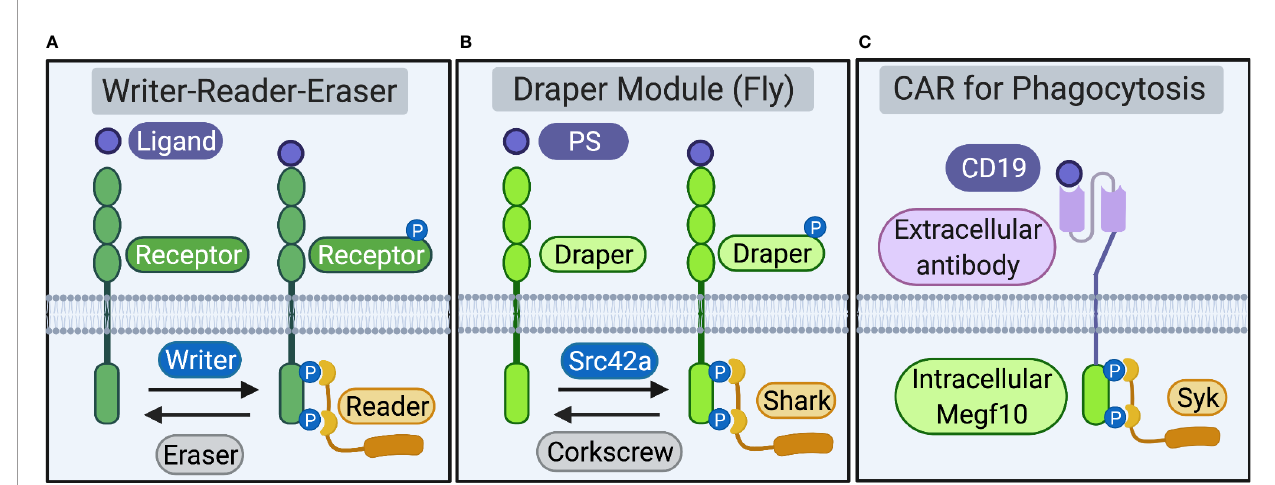
FIGURE 1 | Receptors and proximal writer-reader-eraser modules. (A) Schematic of a generalized receptor and writer-reader-eraser module. Receptor ligation induces phosphorylation of a receptor intracellular signaling domain by a writer kinase. The phosphorylated receptor recruits a reader adaptor protein. An eraser phosphatase removes phosphorylation marks on the receptor intracellular domain, returning the system to its resting state. (B) A writer-reader-eraser module regulates signal transduction through the Draper receptor. Draper, expressed on fruit fl y phagocytes, recognizes phosphatidylserine (PS) or other ligands. Phosphorylation of the Draper intracellular domain by the kinase Src42a induces recruitment of the adaptor kinase Shark. The phosphatase Corkscrew erases phosphorylation marks on the intracellular domain of Draper. (C) Chimeric Antigen Receptor for Phagocytosis (CAR-P). Synthetic CAR-Ps bind cancer antigens (e.g. the B cell antigen CD19) via an extracellular single-chain antibody fragment (scFv). Extracellular antibody ligation induces phosphorylation of engulfment receptor signaling domains (e.g. the intracellular domain of mouse Megf10). Phosphorylation of the Megf10 receptor signaling domain on CAR-P recruits the Syk adaptor, a cognate reader for murine Megf10. Schematic created in BioRender